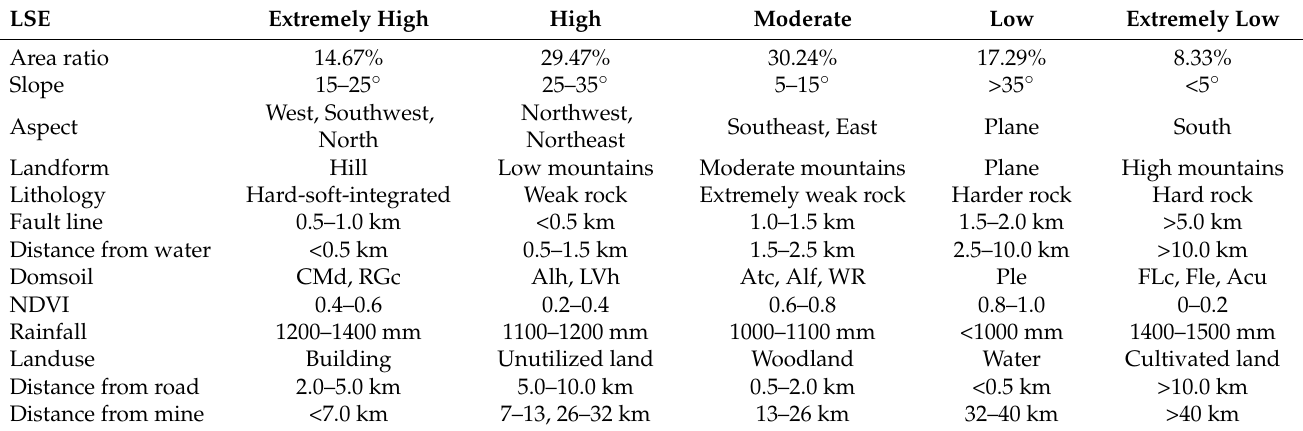
Table 5. LSE results and influencing